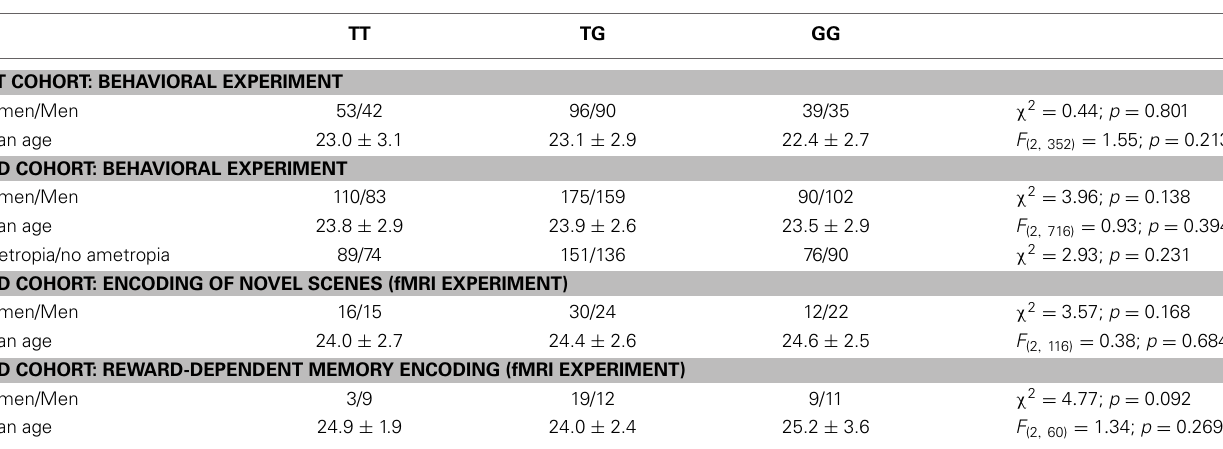
Table 1 | Demographic